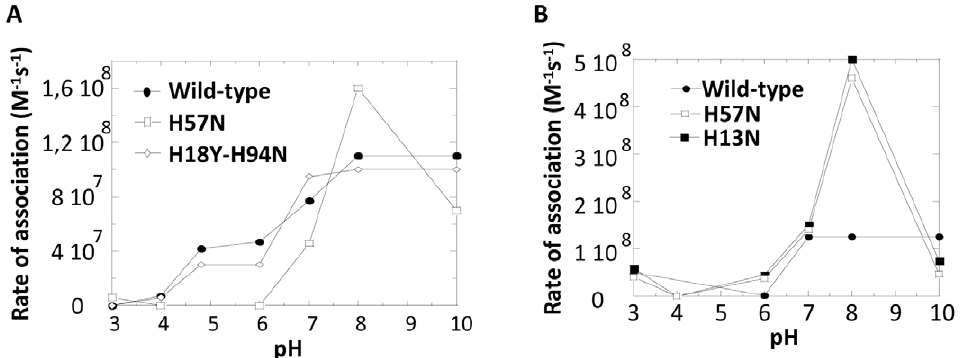
Figure 6. pH-dependence of the association rates determined by SDA (simulation of diffusional Association). Rates of association were computed at different pH for the wild-type toxin and for the histidine mutants by Brownian Dynamics simulation. A. Rates of association of CtxB subunits. For the sake of clarity only mutants H57N and H18Y-H94N are indicated on the figure. H13N and H13N-H57N gave similar results than H57N and H18Y and H94N gave similar results than H18Y-H94N. B. Rates of association of LTB subunits. The rates of association of wild-type and the two histidine mutants H13N and H57N are shown. The rates of association are calculated for two native independent contacts at an intermolecular distance of 6 A˚.